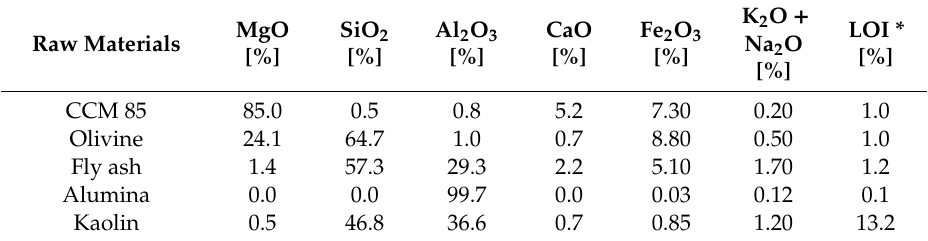
Table 1. The chemical composition of used raw materials.